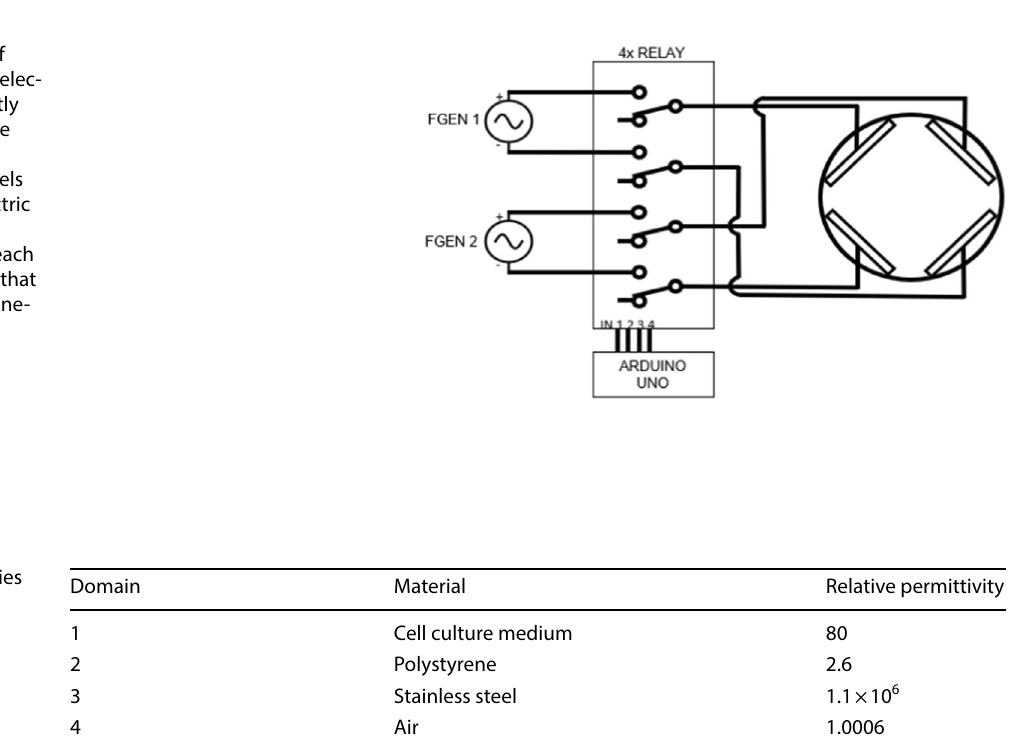
Fig. 1 Setup and layout of TTField delivery in vitro. A Separate function generator channels are connected to paired relays that control the activation of parallel electrodes. An Arduino controls commutation time and activation time of parallel electrodes. B Electrodes are wired together in series and fit into the lid of a 6-well cell culture plate via laser-cut slits reinforced by 3D-printed, high-temperature resin that can withstand an autoclave environment. C Electrodes sit within each well < 1 mm from the bottom of the well and ~ 10 mm within the cell cul- ture media. A polystyrene microscope cover slip with cells seeded onto it sits between the electrodes